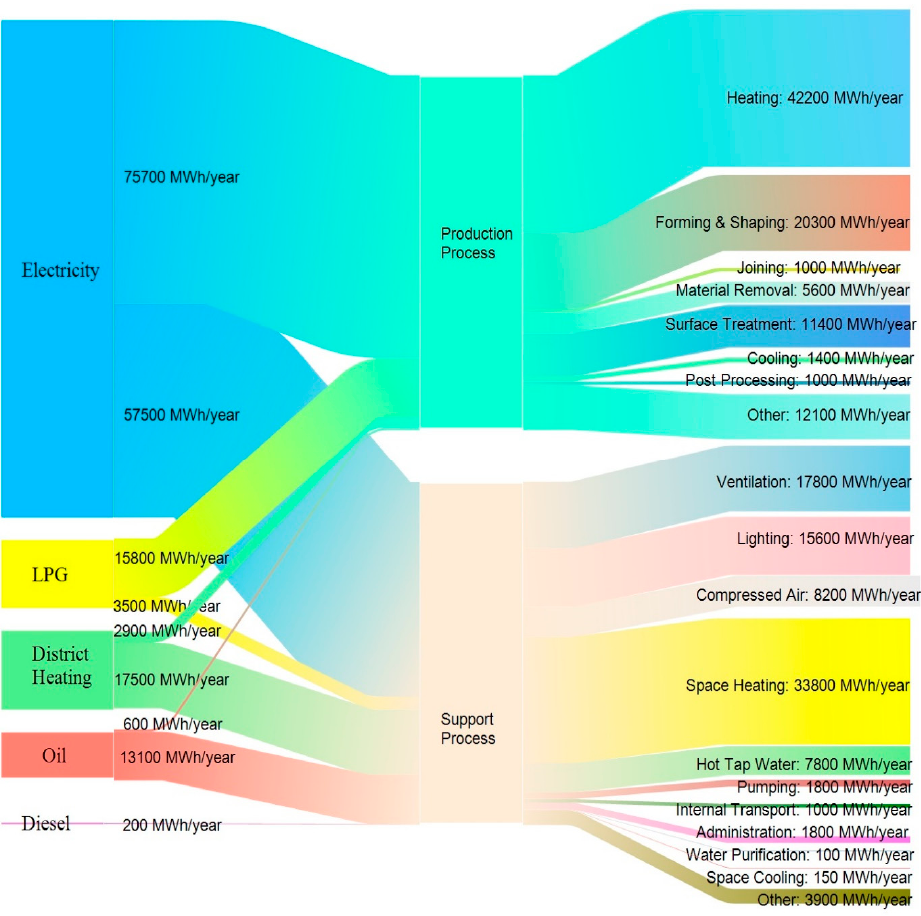
Figure 7. Energy flow through different taxons and categories of EEU taxonomy for the Swedish engineering industry (values are rounded to nearest 50 or 100).